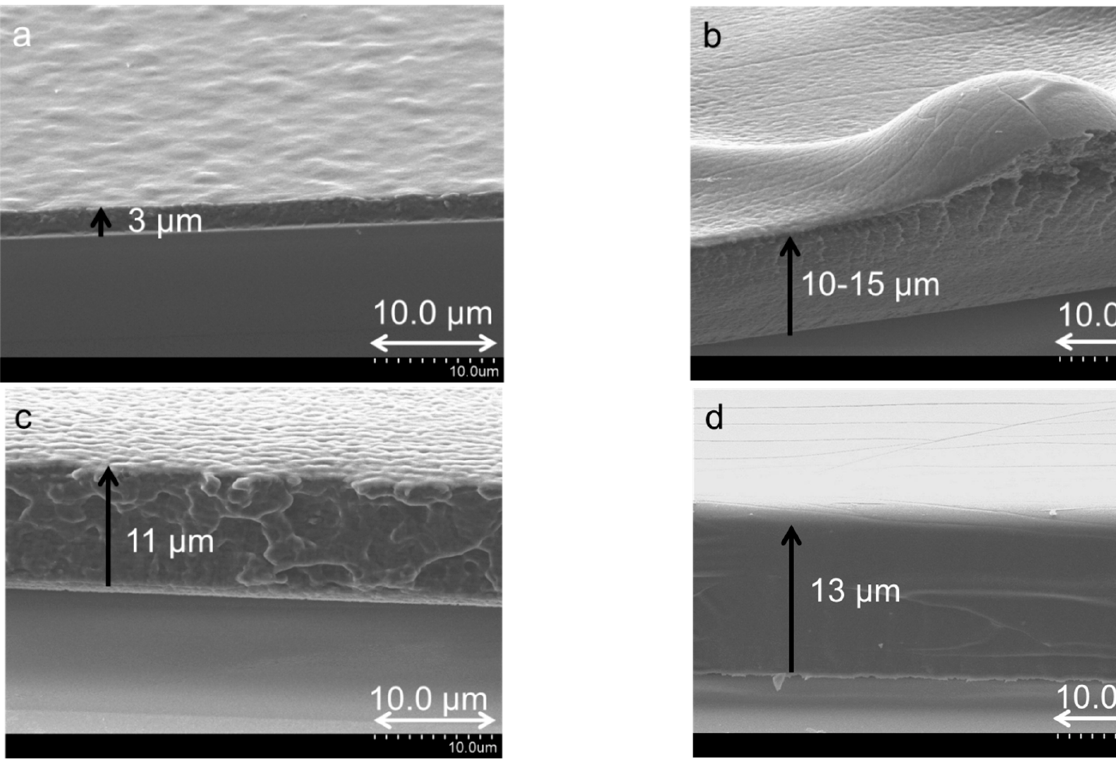
Figure 7. SEM cross-section images of 100 layers of ( a ) PDDA-[Laponite + PAA, 4:1], ( b ) PDDA- [Laponite + PAA, 3:2], ( c ) PDDA-[Laponite + PAA, 2:3], and ( d ) PDDA-[Laponite + PAA, 1:4] multilayers. Lines with arrows indicate the thickness of the film deposited on the substrate. Table 2. Comparison of structural properties among the four systems in which laponite and PAA were combined in solution and deposited together for the multilayer